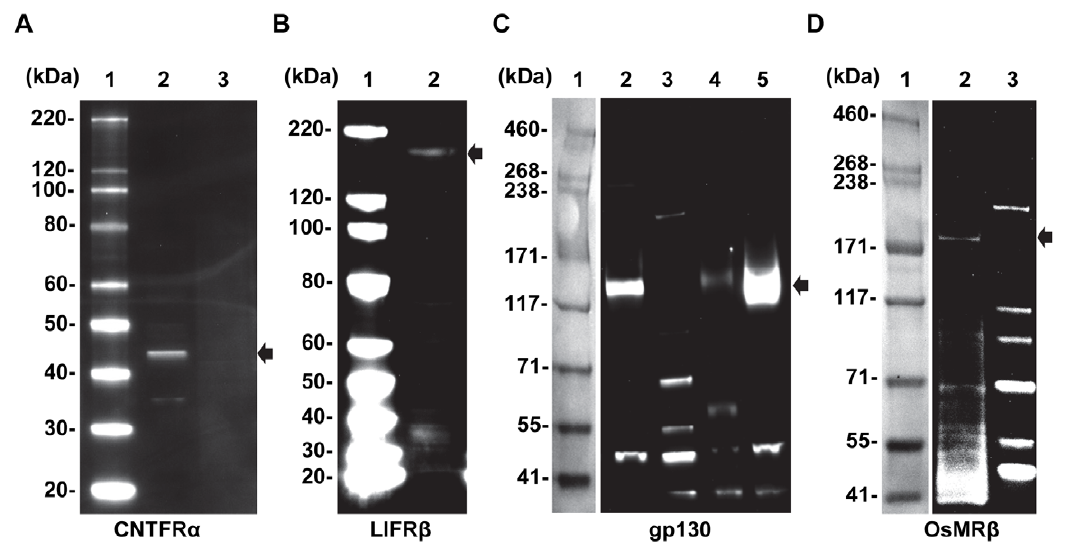
Figure 4. Constitutive expression of CNTF, CT1, OsM receptors in human RPE. 15 m g of enriched membrane proteins were electrophoresed and labeled with corresponding antibodies. Antibody specific bands (see arrows) for CNTFR a , LIFR b , gp130 and OsMR b are detected at approximately 41, 190, 130, and 200 kDa, respectively. Panel A (CNTFR a ) - Lane 1: Magic Mark TM XP Western protein Standard; Lane 2: Brain (Human) membrane lysate-adult normal tissue; Lane 3: hfRPE membrane extract. Panel B (LIFR b ) - Lane 1: Magic Mark TM XP Western protein Standard; Lane 2: hfRPE membrane extract. Panel C (gp130) - Lane 1: HiMark TM Molecular Weight (HMW) Standard; Lane 2: hfRPE membrane extract; Lane 3: Magic Mark TM XP Western protein Standard; Lane 4: Hela whole cell lysate; Lane 5: NIH3T3 whole cell lysate. Panel D (OsMR b ) - Lane 1: HiMark TM Molecular Weight (HMW) Standard; Lane 2: hfRPE membrane extract; Lane 3: Magic Mark TM XP Western protein Standard.